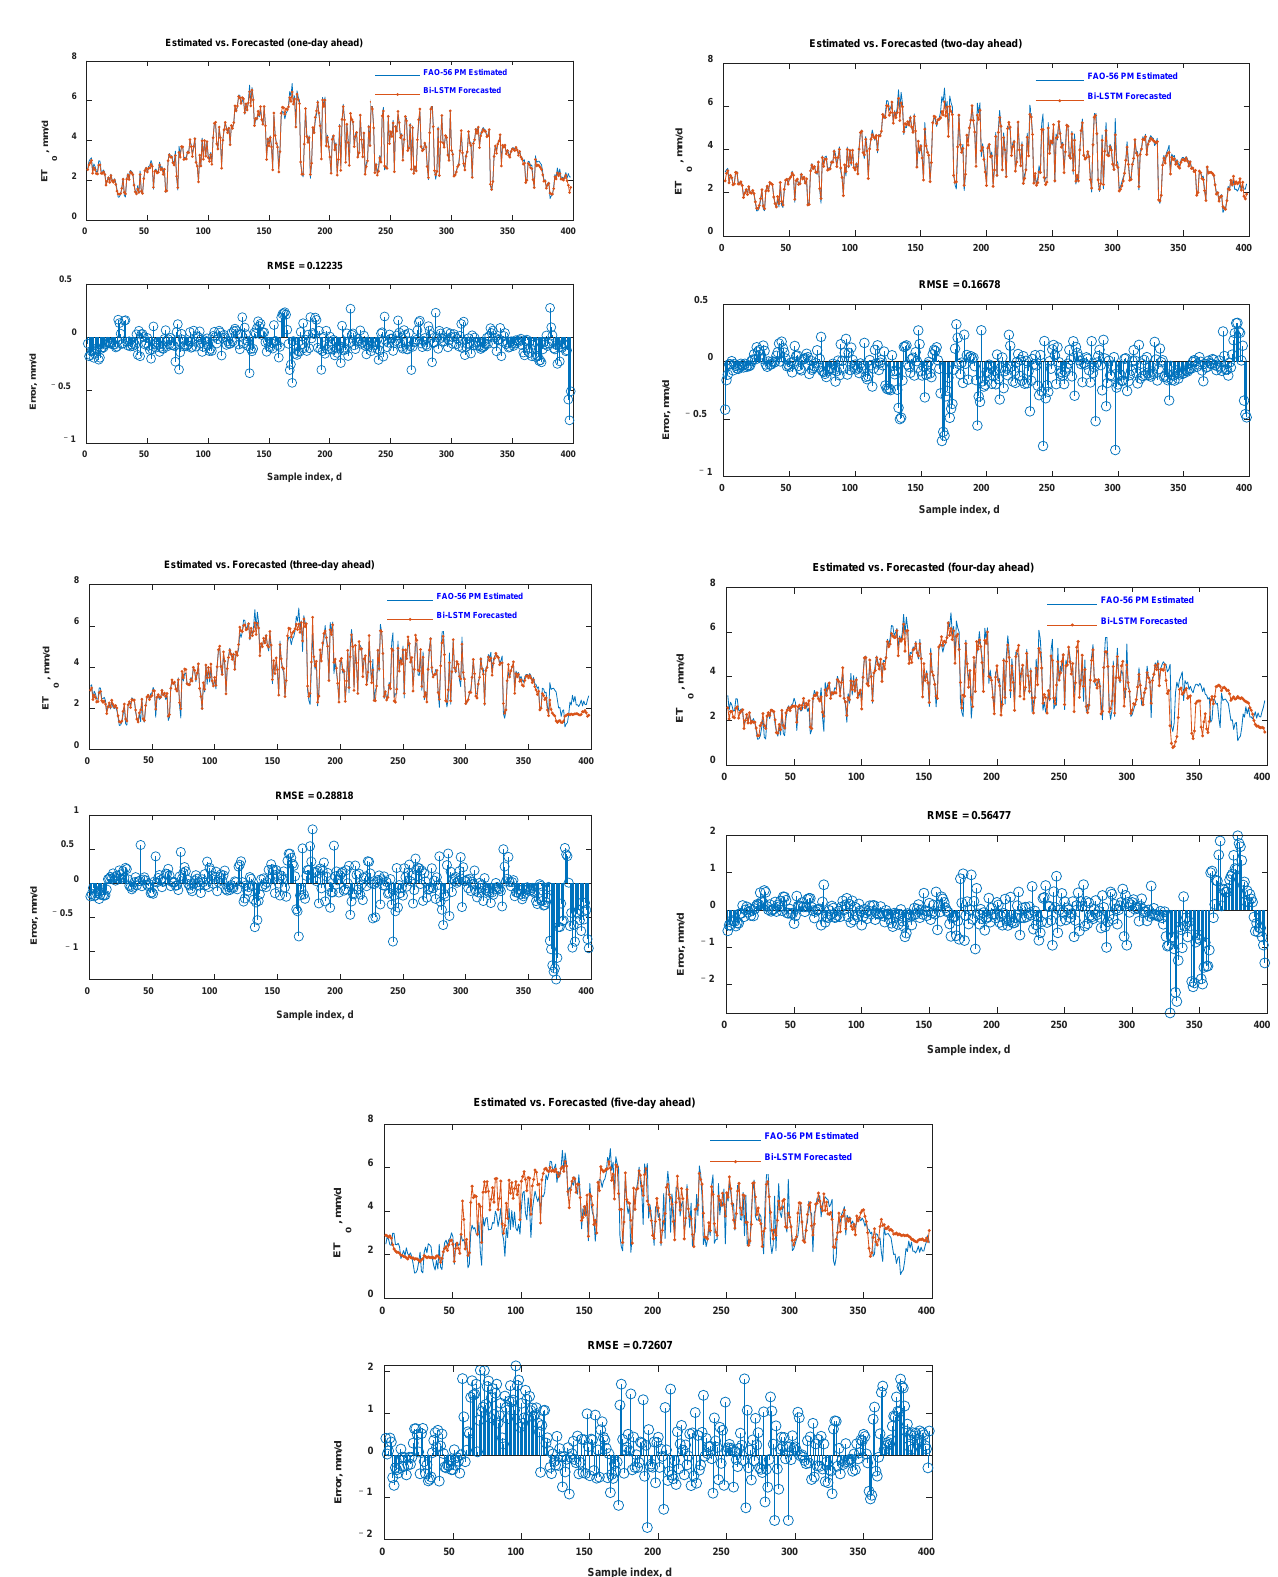
Figure 13. Line graph and error plots for 1, 2, 3, 4, and 5 day-ahead forecasting at Ishurdi station.